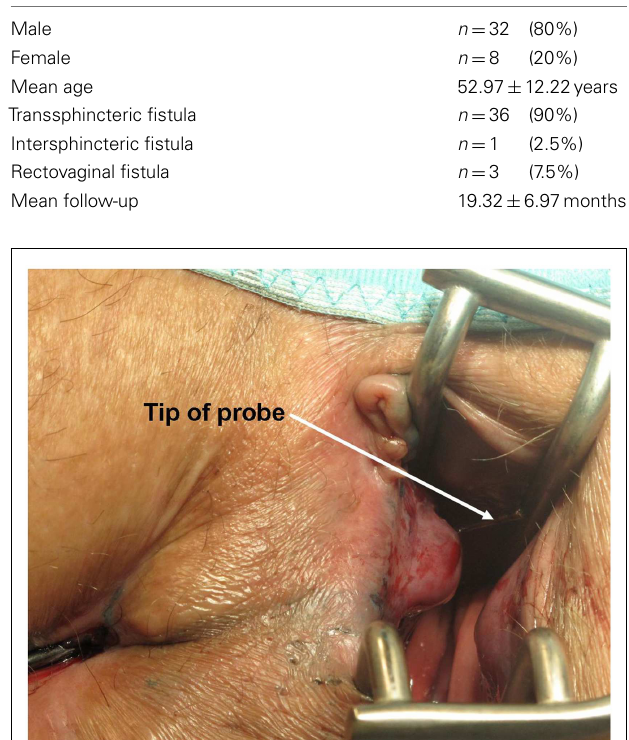
Table 1 | Characteristics of patients with follow-up ( n = 40) .